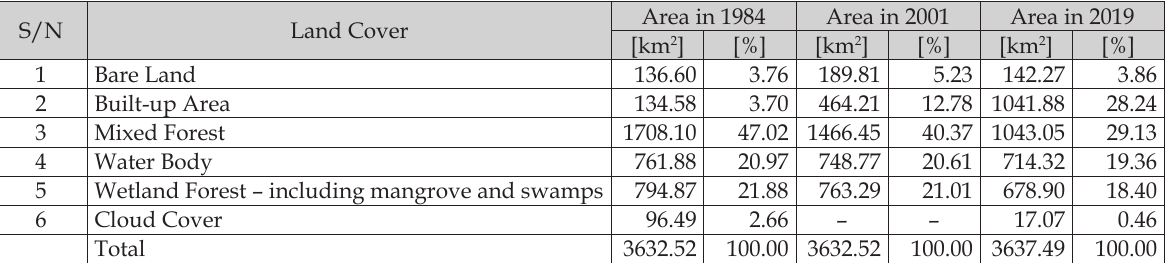
Table 1. Areal distribution in the coverage of land cover between 1984 and